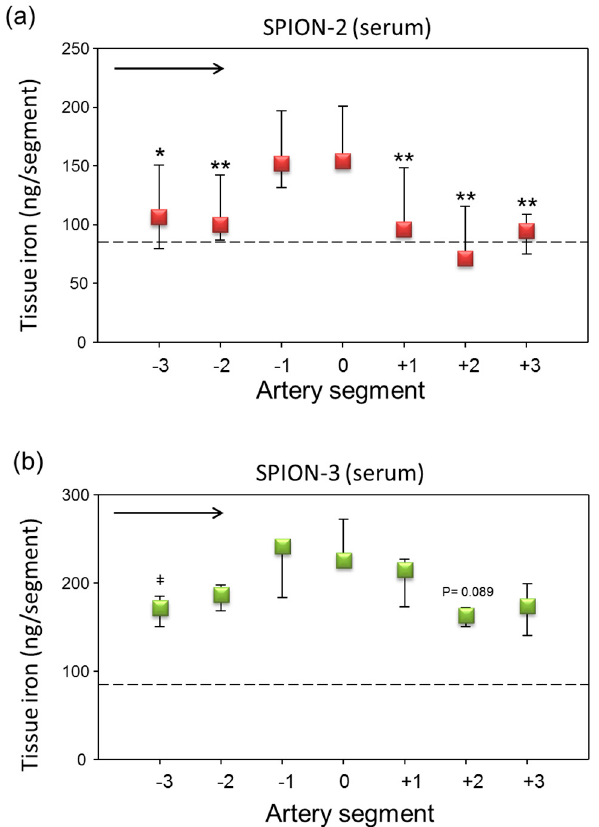
Figure 5. Magnetic targeting of circulating SPION-2 and SPION-3 suspended in serum. ( a ) SPION-2 and ( b ) SPION-3 suspensions at 30 µ g Fe / mL were circulated in the model for 30 min under external magnetic force positioned at segment 0. Arrow indicates the direction of flow. Shown is iron concentration of respective segments (median with 75th and 25th percentile of n = 5 experiments). Average control values (SPIONs suspensions without magnet) are indicated by dashed line. ** P < 0.01, * P < 0.05, versus segment 0; ‡ P = 0.066 versus segment − 1; trend P values are indicated.